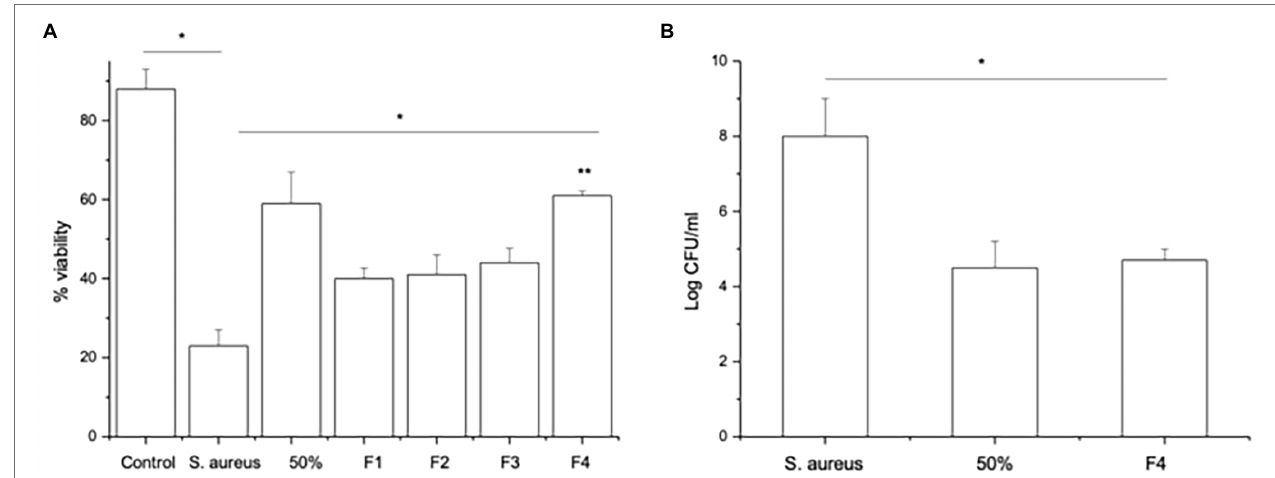
FIGURE 4 | Fraction F4 contains all the anti-adhesive effects of the LGG lysate. (A) The viability of keratinocytes infected with S.aureus and treated either with 50% acetonitrile fraction (50%) or with S. aureus and the F4 HPLC fraction (F4) significantly increased compared to keratinocytes infected with S. aureus alone (* p = 0.04 and ** p = 0.003, respectively). However, the other fractions (F1, F2, and F3) afforded less protection to keratinocytes than cells treated with F4 (* p = 0.02). (B) Cells exposed to S. aureus for 2 h and then treated with either 50% acetonitrile fraction (50%) or HPLC fraction F4 (F4) have significantly fewer staphylococci adhering to the cells than cells infected with S. aureus alone (* p = 0.04). Data are presented as the mean ± SEM., n =